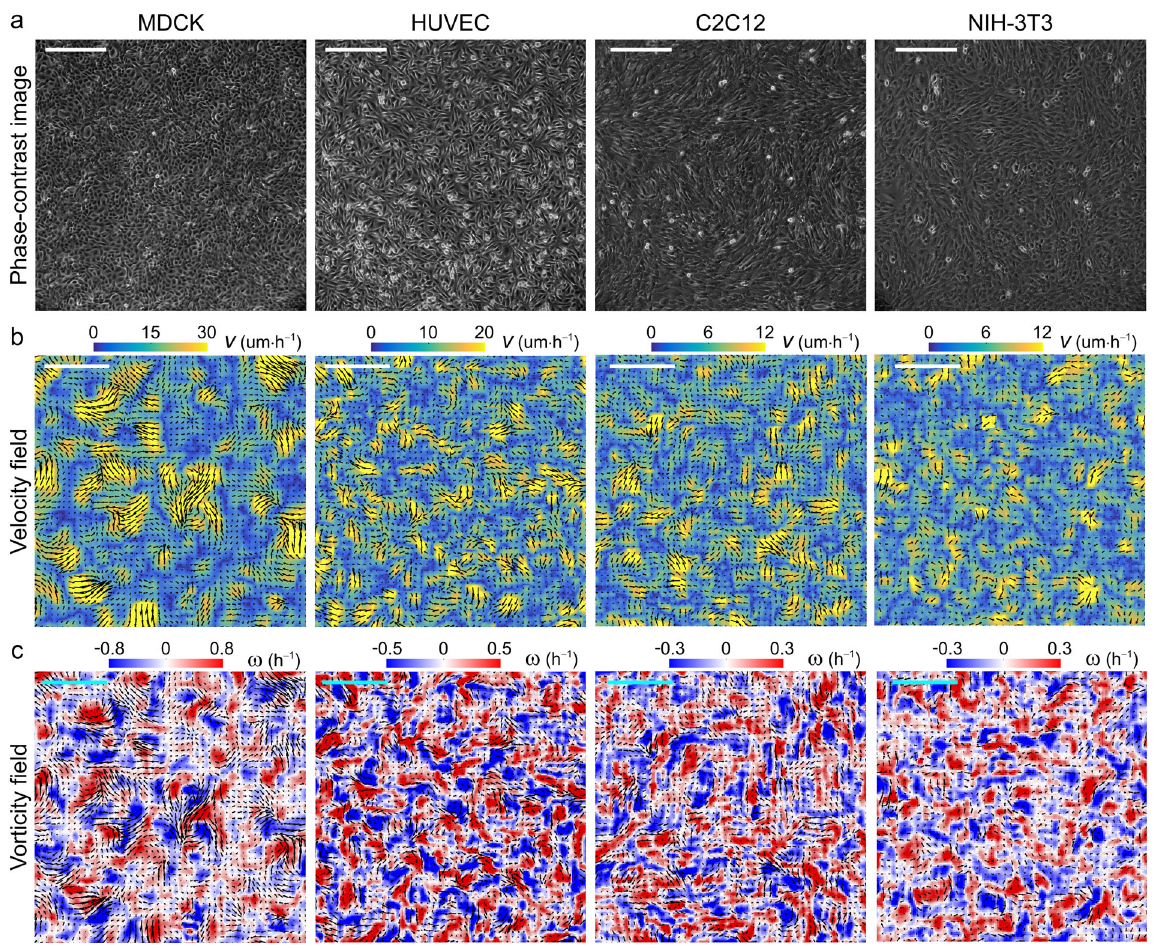
Fig. 1 Turbulent cell dynamics in various cell monolayers. a Representative phase contrast images. MDCK for Madin Darby canine kidney cells, HUVEC for human umbilical vein endothelial cells, C2C12 for C2C12 mouse myoblast cells, and NIH-3T3 for NIH-3T3 mouse embryo fi broblast cells. b , c Representative fi elds of b the velocity and c the vorticity at t = 6 h. The color codes refer to the velocity magnitude and the vorticity intensity, respectively, and the black arrows indicate the velocity vectors. Scale bars, 300 µ